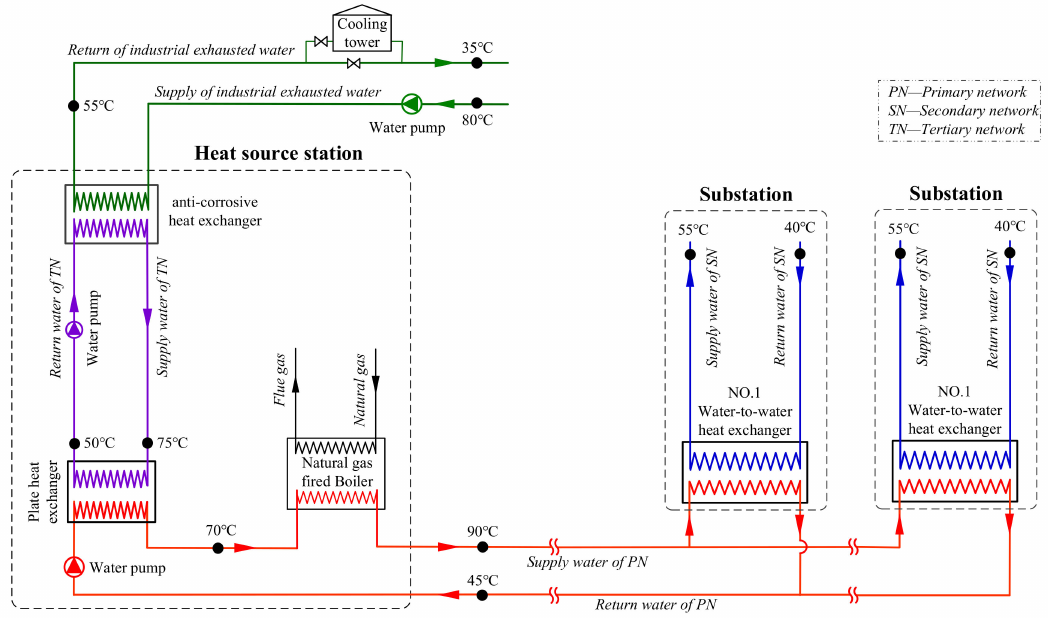
Figure 4. Sketch of conventional central heating system integrated with industrial exhausted heat using heat exchanger